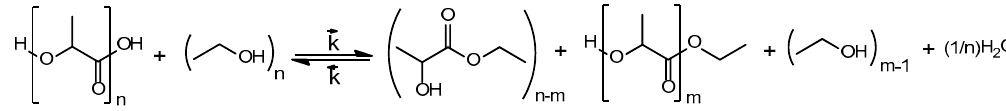
Figure 1. Full reaction scheme for the transesterification of oligomeric LA to ethyl lactate including equilibrium (free) ethanol, water liberated by end-group esterification, and the oligomeric ester fraction (valid for an equimolar mixture of ethanol and lactate units in the oligomer and n > m).